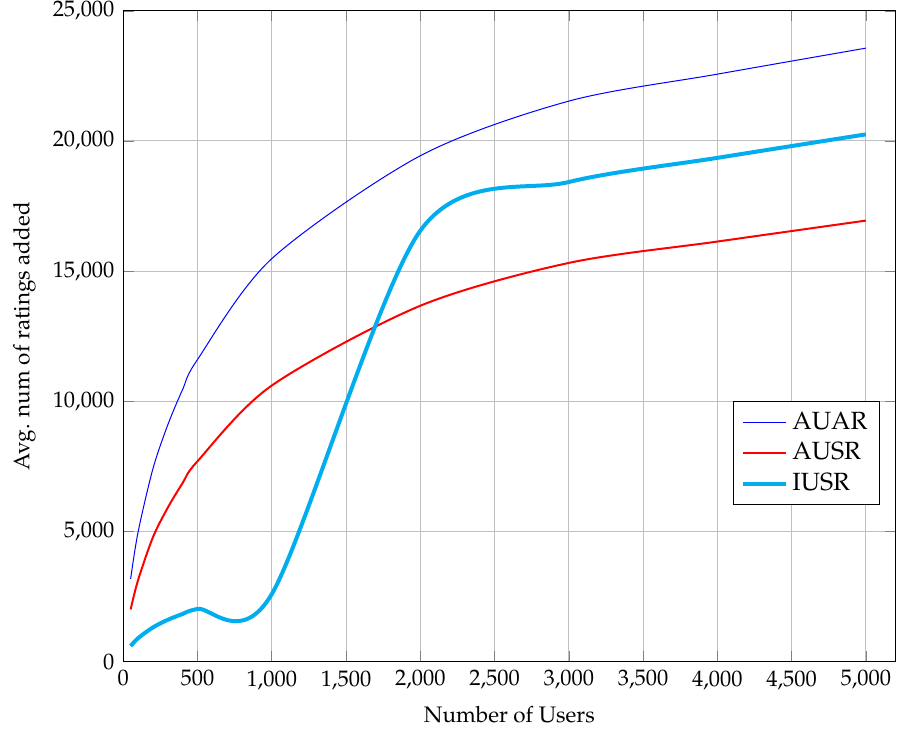
Figure 2. Average number of ratings added for different number of replicated users in each